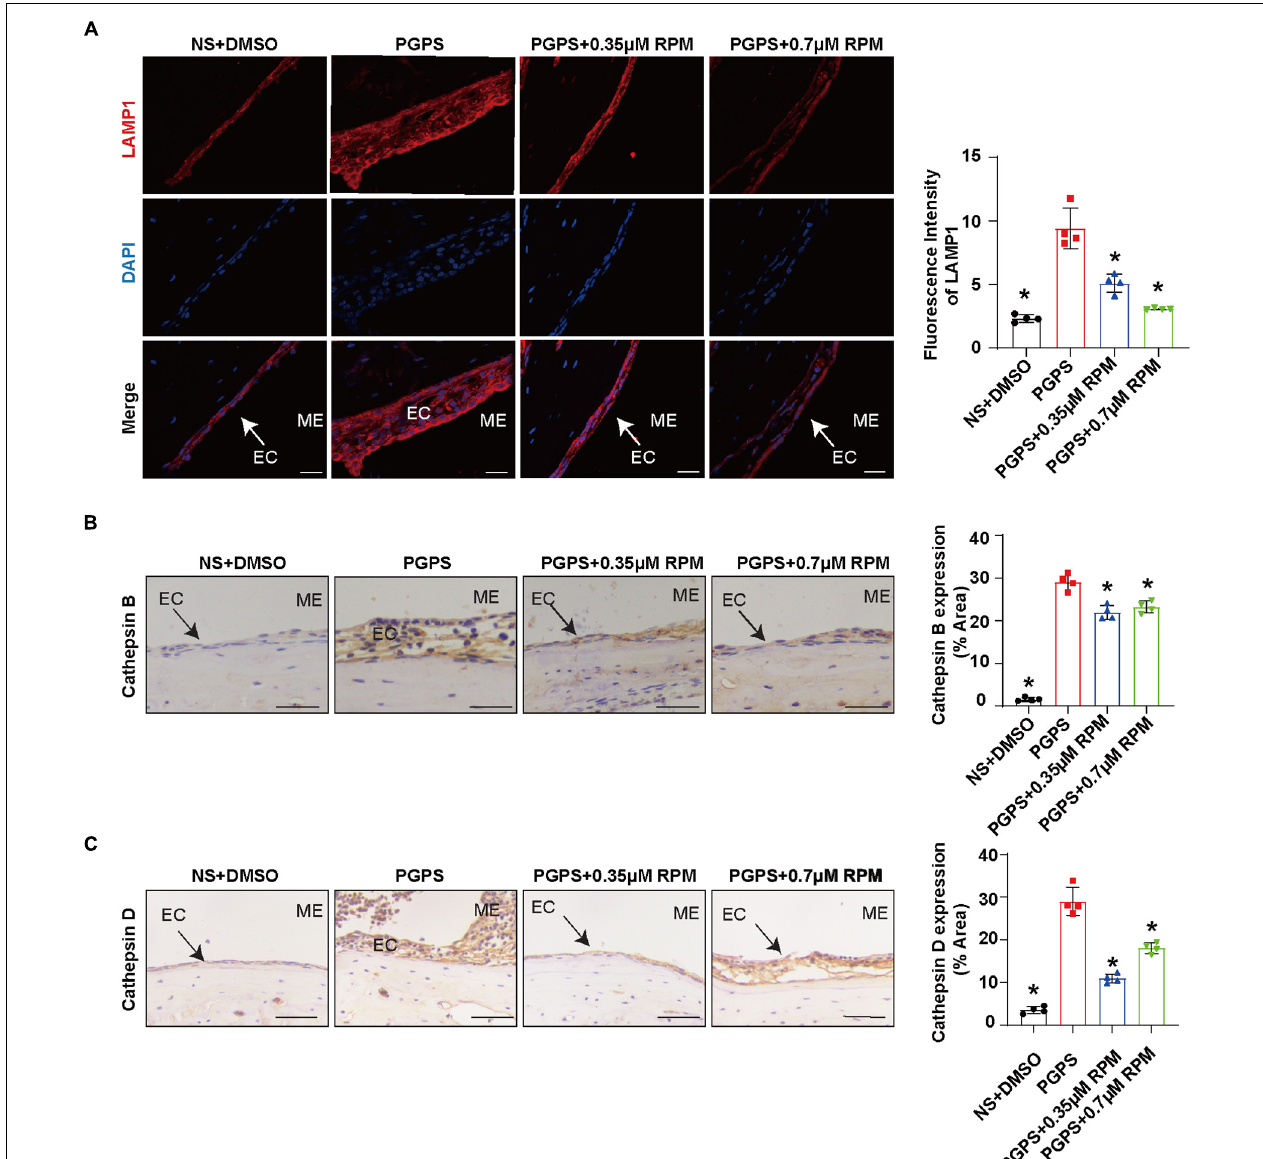
FIGURE 7 | Lysosome function may not be impaired after PGPS injection Mice were inoculated with PGPS or a combination of PGPS and either 0.35 or 0.7 µ M RPM. Paraffin-embedded sections of ME tissues were immunostained antibodies. (A) The representative images and quantification of LAMP1 expression in ME tissues. (B) The representative images and quantification of Cathepsin B expression in ME tissues. (C) The representative images and quantification of Cathepsin D expression in ME tissues. n = 4 per group, ME represents the middle ear; EC represents epithelial cells. * P < 0.05 vs. the PGPS group, one-way ANOVA, Scale bar = 25 µ